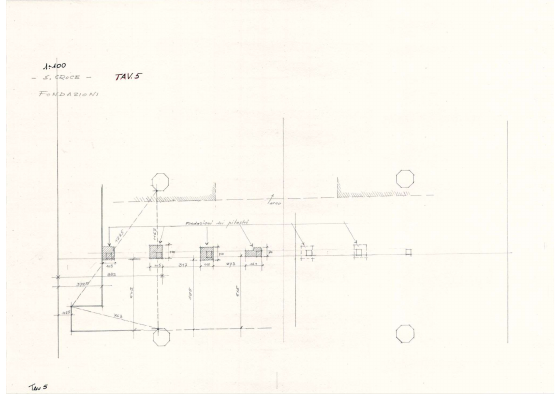
Figure 3 . Plan drawing of the groundworks of the tramezzo (c.